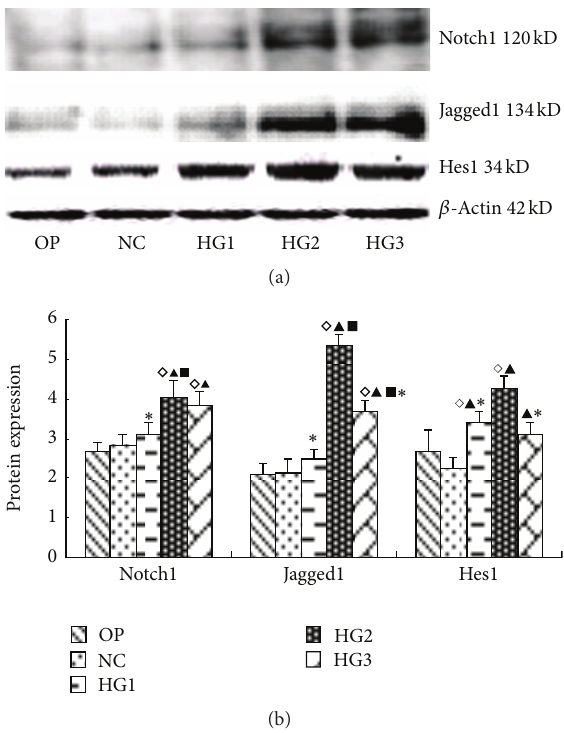
Figure 1: The expression of Notch pathway components as mea- sured by Western blotting following treatment of GMC with various glucose concentrations for 24 h. (a) Notch-associated molecule pro- teins at different glucose concentrations and high osmotic pressure at 24h. Notch-associated molecules increased in the high glucose group; they had the most significant changes in the HG2 group, but there were no apparent differences between the NC group and the OP group. (b) The gray graph shows the relative statistical values of Notch-associated molecules for each group. The expression of the Notch-associated molecules increased in the high glucose group, especially, in the HG2 group. ◊ 𝑃 < 0.05 versus OP group; 󳵳 𝑃 < 0.05 versus NC group, ◼ 𝑃 < 0.05 versus HG group; ∗ 𝑃 < 0.05 versus HG2 group.